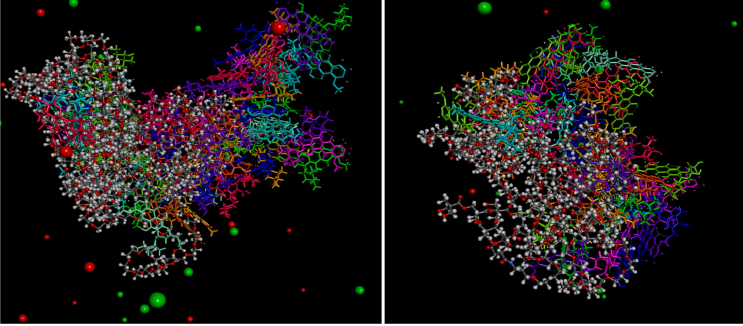
Figure 7. Snapshots of the complex of PEGylated hyperbranched polyesters and doxorubicin. Doxorubicins are represented as differently colored sticks. The PEGylated polyesters are depicted in ball and stick form. The ions Na + and Cl − are shown as red and green beads, respectively. (Reprinted with permission from [135]. Copyright